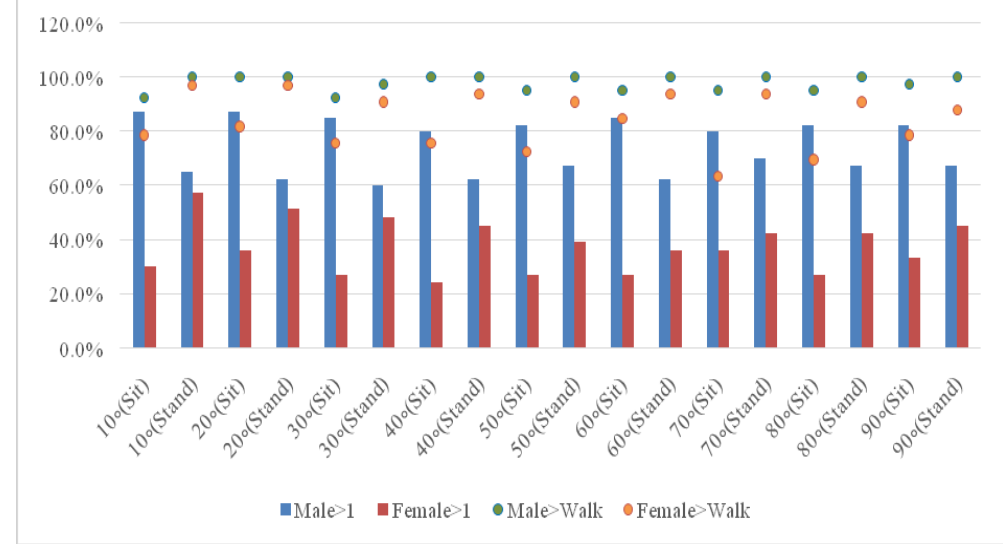
Figure 6. Percentage of VMO that was greater than VL and VMO kicking action that was greater than the percentage of walking at each